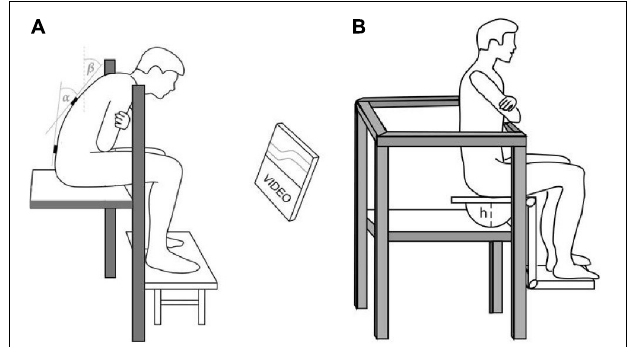
FIGURE 1 | (A) During intermitant flexion exposure participants obtained ∼ 80% of their available lumbar flexion ( α ) and 35 ◦ of trunk inclination ( β ) using real-time visual feedback. Additionally in the supported condition a padded bar was placed in front of the participant at appropriate height in order to lean on it while obtaining the required trunk position. (B) Postural control assessment on a custom-built chair with a hemi-sphere attached below the seat surface [height (h) = 18